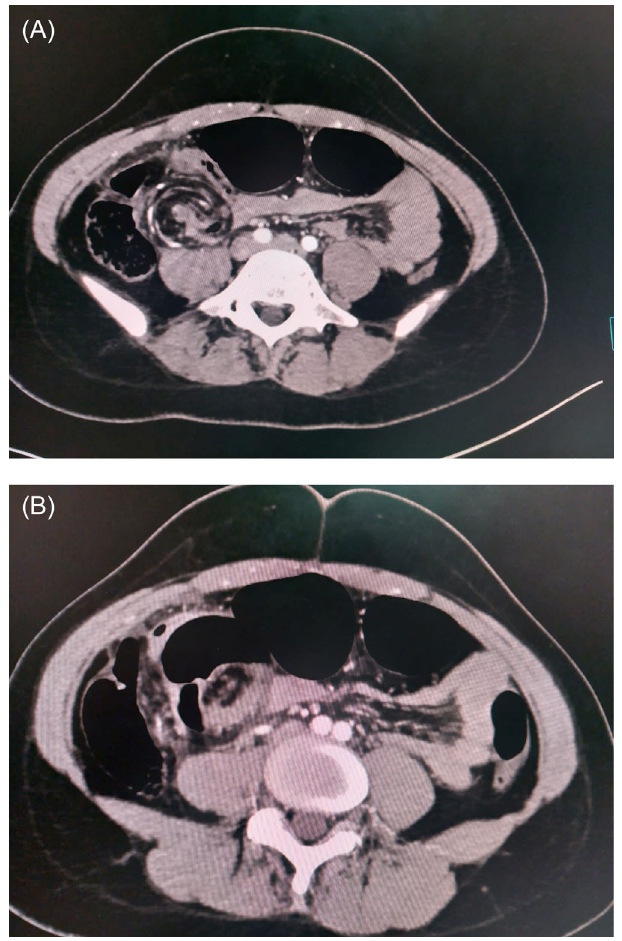
Figure 2. Major caecal distension related to a caecal volvulus responsible for parietal thinning and a fatty mesentery with low attenuation after contrast